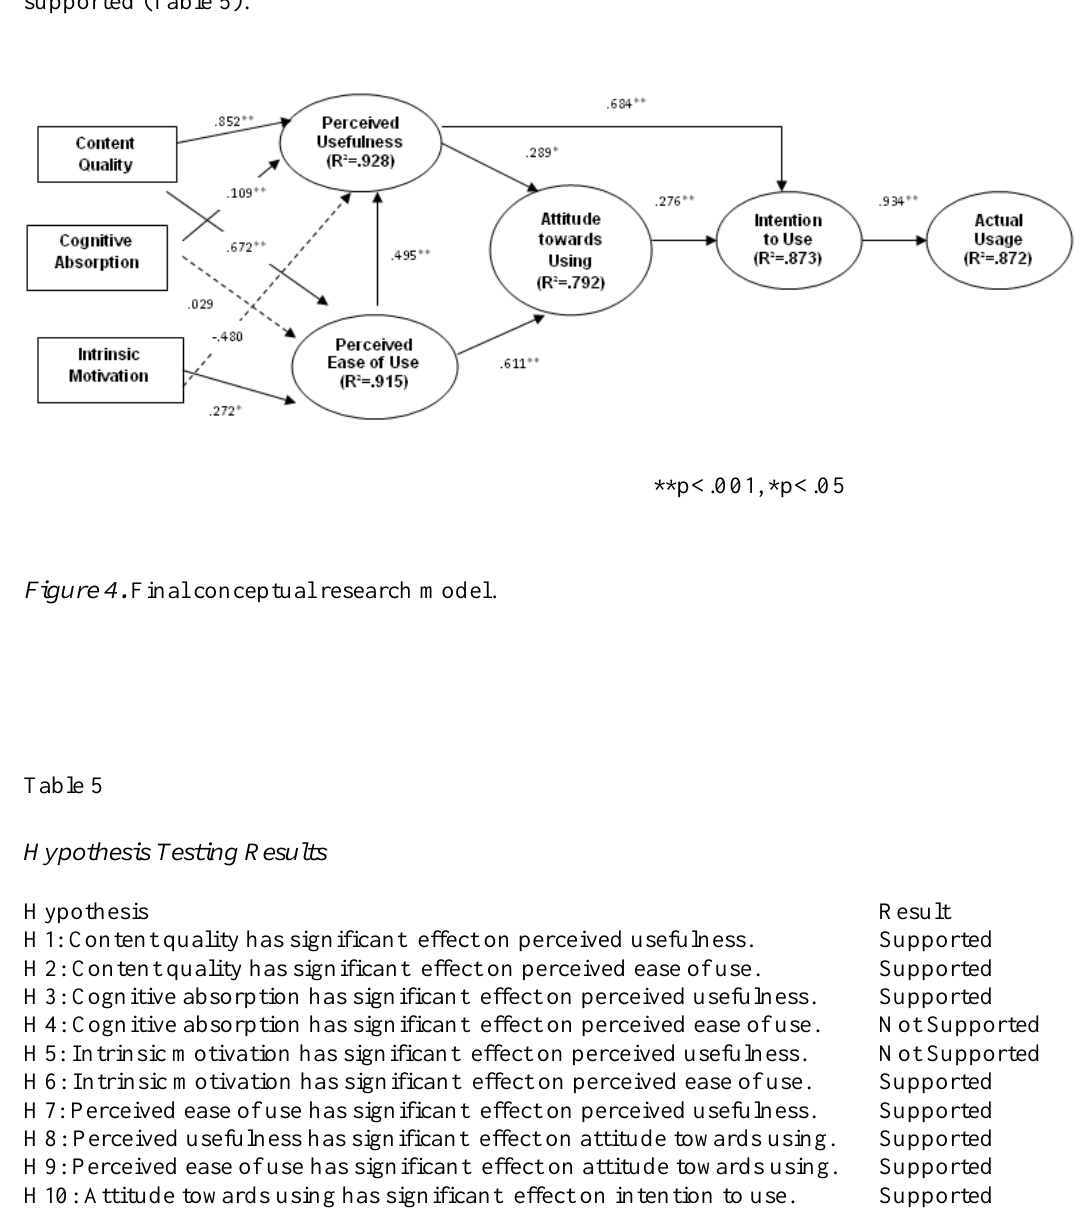
Hypothesis Testing Results